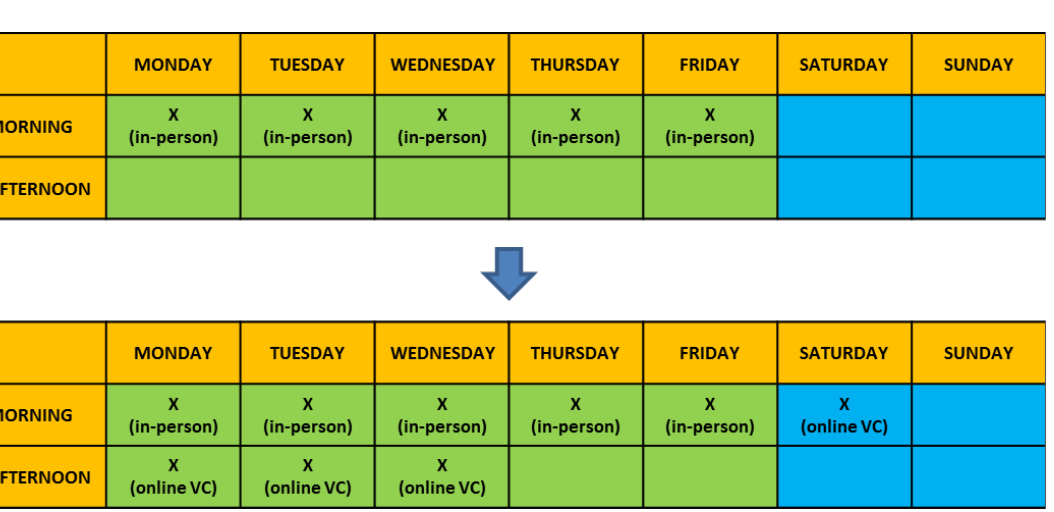
Figure 1. Modified timetable of scheduled appointments. “In-person” appointments were provided of 3 supplemental afternoons available slots for video consulting during the working week and 1 morning over the weekend, for adults patients